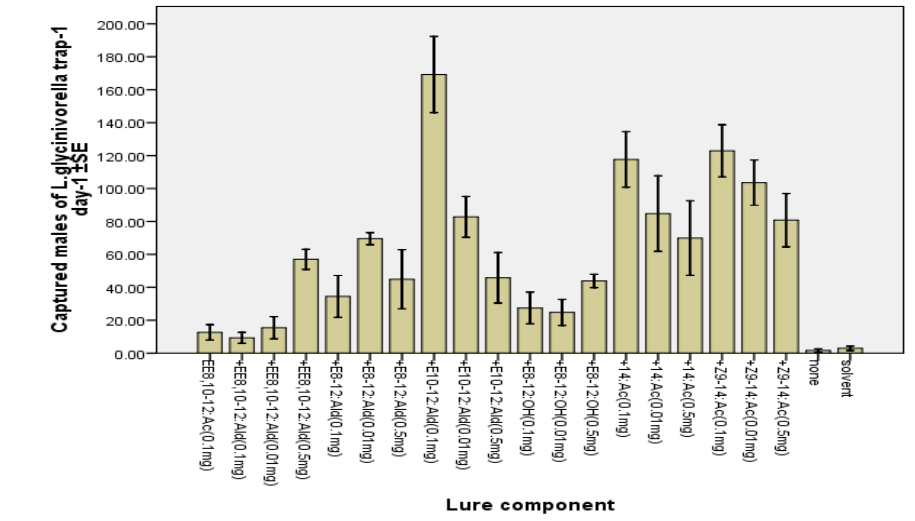
Figure 4. Attraction of L. glycinivorella males in traps baited with the binary blend of EE- 8,10-12:Ac (0.1 mg) and nine different synthetic compounds at three doses (0.01, 0.1, and 0.5 mg) in a soybean field in Harbin, China, from 11 August to 17 August 2011. Catches followed by different letters within one column are significantly different at p = 5% by Tukey’s HSD [capture data were transformed to log(x + 1) before performing